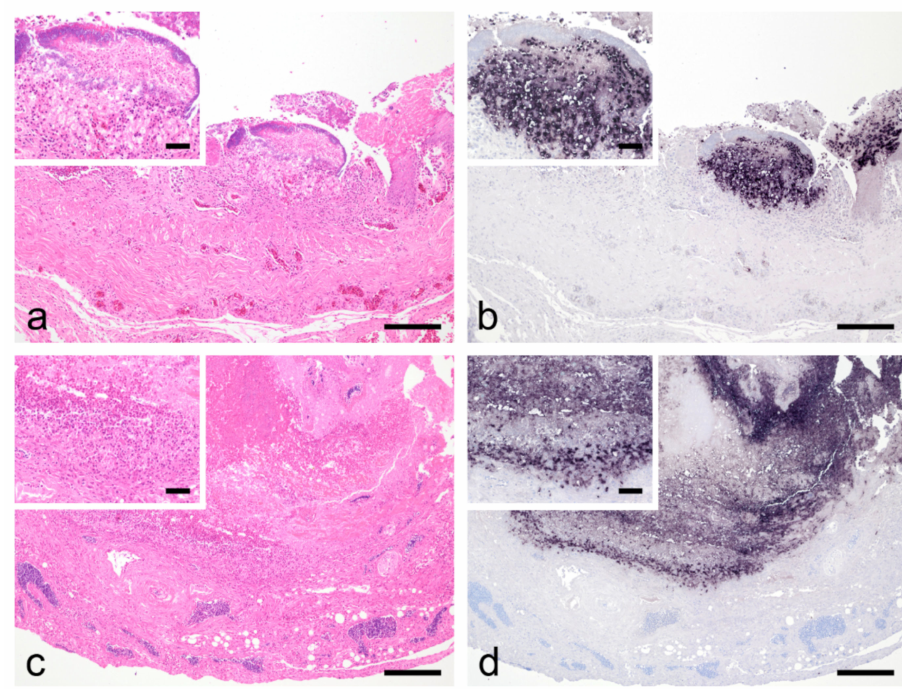
Figure 3. ( a ) Greenfinch, esophagus with predominantly superficial heterophilic inflammation, mucosal ulceration and bacterial growth (H&E staining, bar = 160). Insert shows fibrin formation, infiltration of heterophils, intralesional and superficial coccoid bacteria (H&E staining, bar = 40 µ m); ( b ) Esophageal wall of the same bird; ISH reveals abundant colonization with T. gallinae appearing as purple to black stained objects (bar = 160). Insert shows higher magnification of positive ISH (bar = 40 µ m); ( c ) Bullfinch, esophagus with severe transmural heterophilic inflammation and necrosis (H&E staining, bar = 160). Insert shows high-grade diffuse infiltration with heterophils (bar = 40 µ m); ( d ) Esophageal wall of the same bird; ISH reveals large amounts of purple to black stained protozoal objects corresponding to T. gallinae within the necrotic and inflamed tissue sites (bar = 160). Insert shows higher magnification of positive ISH (bar = 40 µ m).